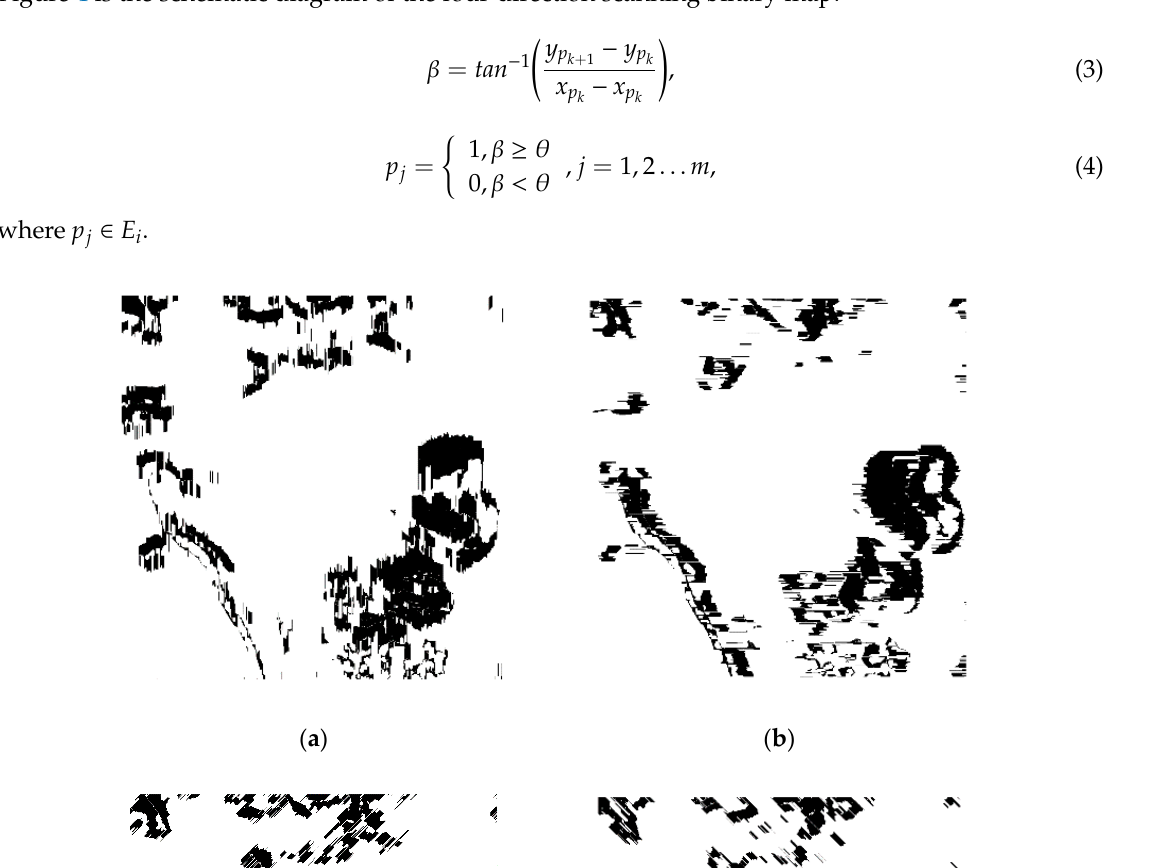
Figure 5. Obstacle binary map of cutting zone. The black area is the obstacle area, which retains the typical details of the four-direction scanning binary maps.